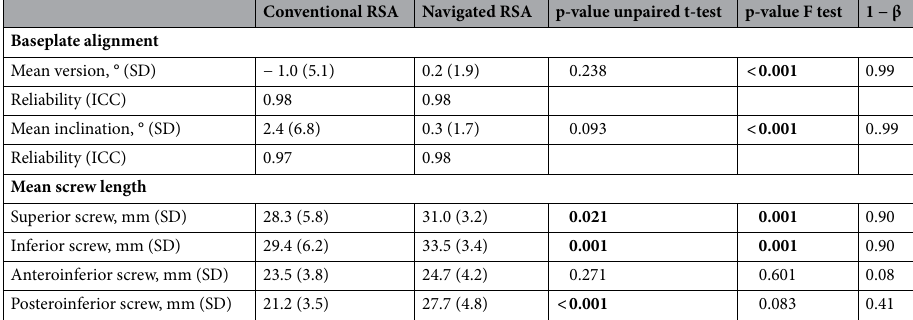
Table 3. Baseplate alignment and Mean screw length for baseplate fixation. SD standard deviation, ICC intraclass correlation coefficient. Significant values are given in bold. p < 0.05 is considered statistically significant.